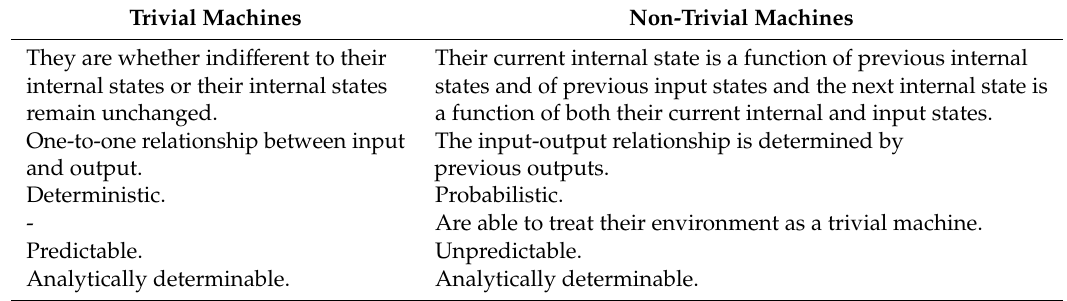
Table 1. The di ff erence between trivial and non-trivial machines according to Heinz von Foerster. Trivial Machines Non-Trivial